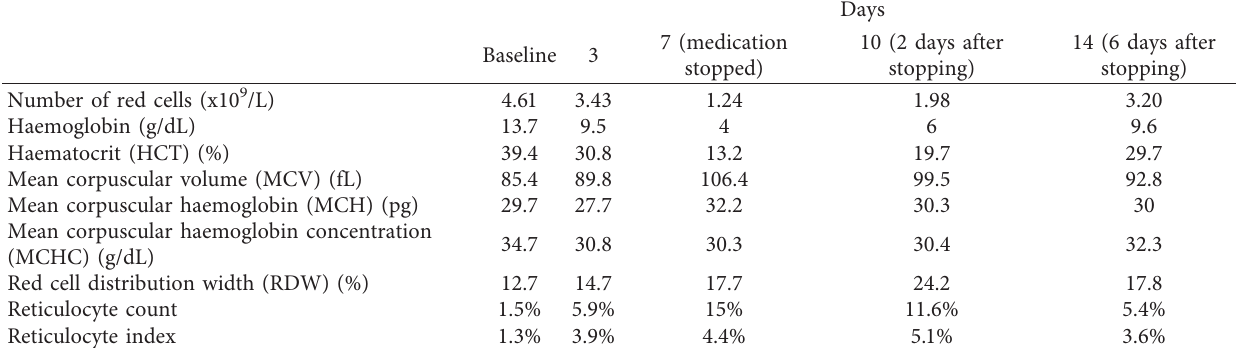
Table 1: Changes in haemoglobin and red cell